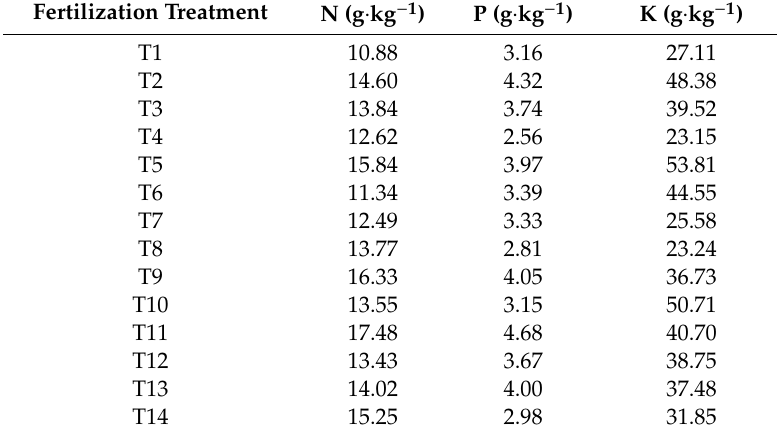
Table 3. Phoebe bournei seedling N, P, and K contents at the end of the trial for the 14 fertilization treatments. Details of the fertilization treatments are found in Table 2.